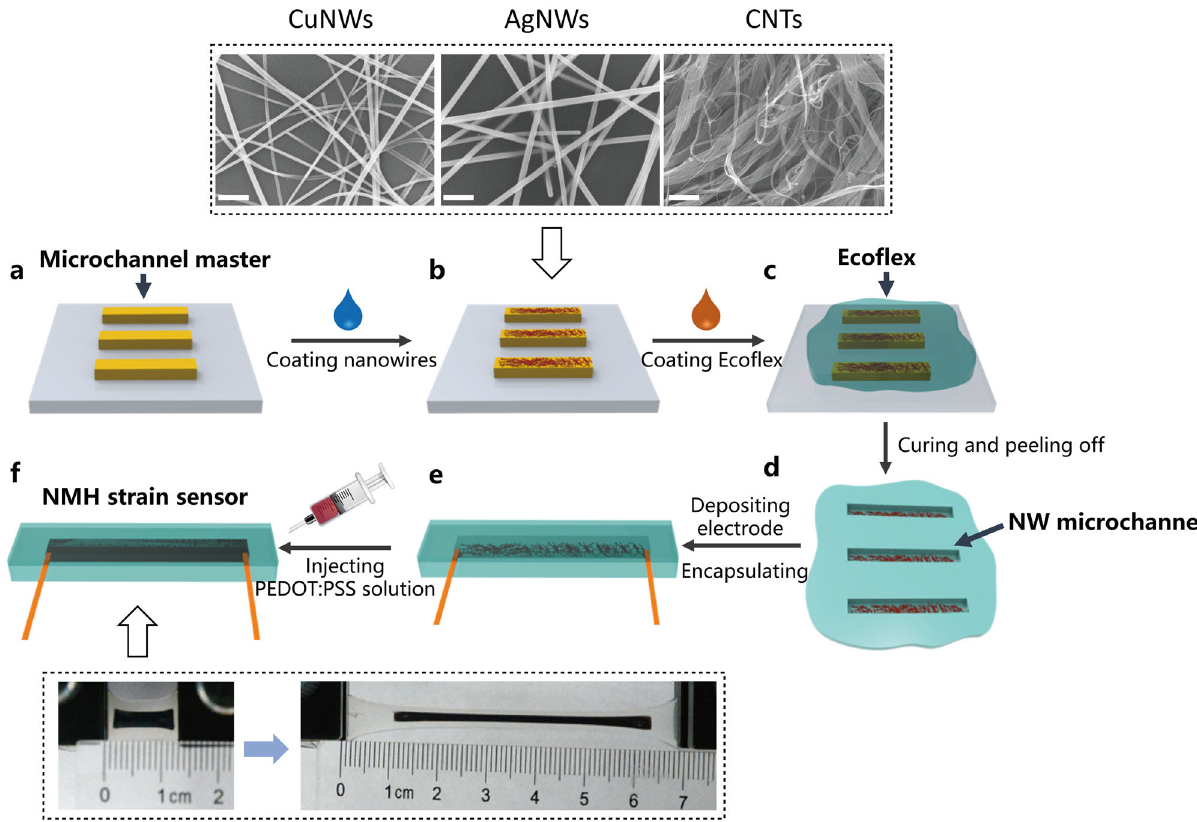
Fig. 1 Schematic diagram of the fabrication process for the nanowire-micro fl uidic hybrid (NMH) strain sensor. a Attach PI tape to a glass substrate. b Deposit nanowires or nanotubes onto the PI tape to form conductive thin fi lms. Scanning electron microscopy (SEM) images of the synthesized copper, silver nanowires, or carbon nanotubes are shown above (the scale bars represent 400 nm). c Pour and impregnate the conductive thin fi lm with uncured Eco fl ex. d Peel off the Eco fl ex fi lm after curing. e Attach silver wires and encapsulate. f Inject the PEDOT:PSS solution and seal the channel with Eco fl ex. Photos of the obtained NMH sensors under different scales of stretching are also